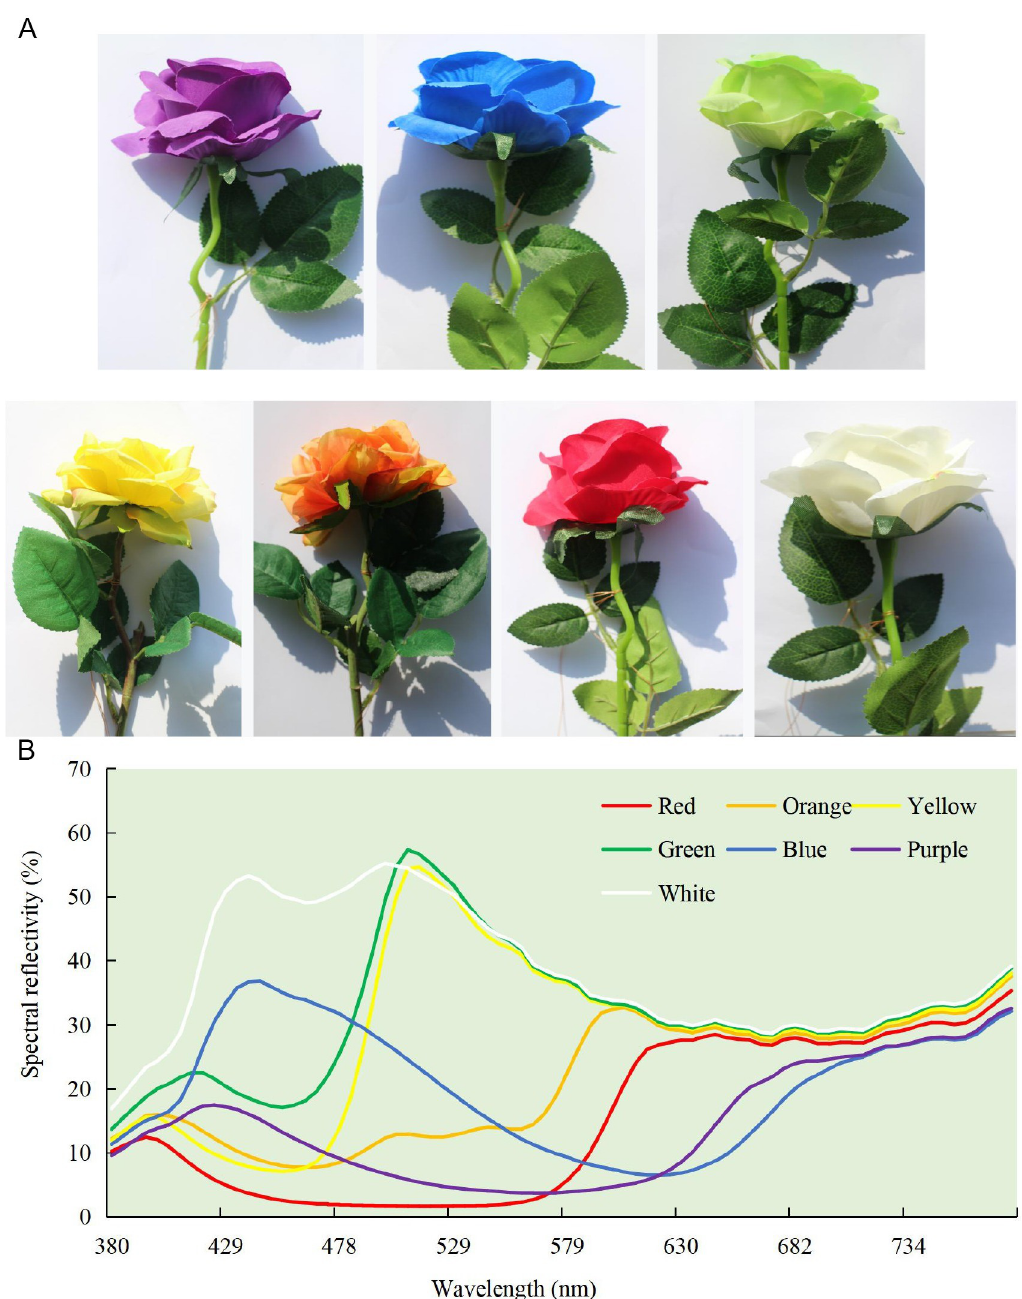
Fig 1. Artificial flowers and their spectral reflectance. A. Artificial flowers with seven colors; B. Spectral reflectance of the seven colors. Observation of courtship behavior. Natural population courtship . In the net house, 10